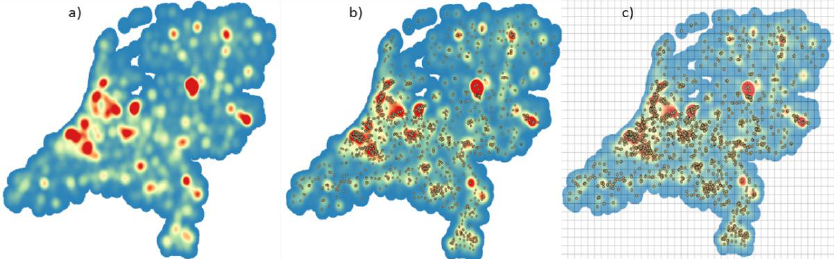
Figure 5. Parking Lots density raster ( a ) with chargers points overlapping ( b ) and cell assignment by matrix generation ( c ).